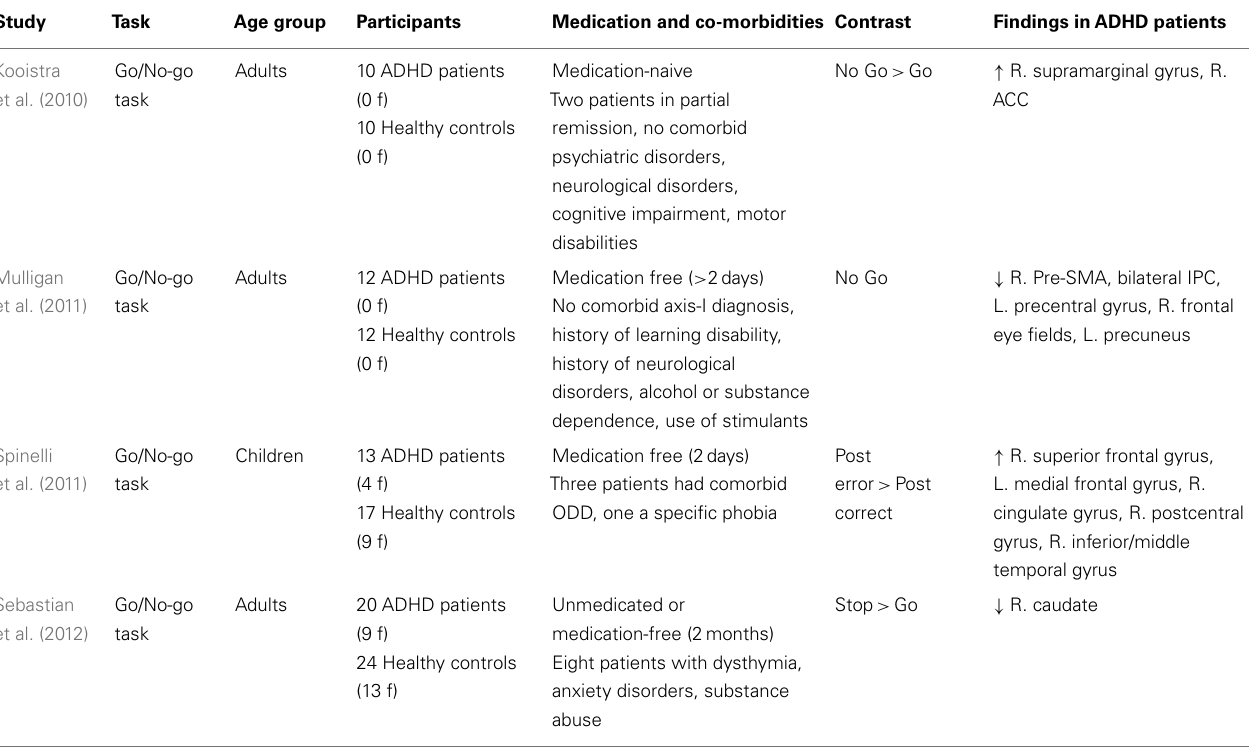
ACC,anteriorcingulatecortex;DLPFC,dorsolateralprefrontalcortex;FS,failedstop-trials;IFG,inferiorfrontalgyrus;IPC,inferiorparietalcortex;f,female;L,left;MPFC, medial prefrontal cortex; ODD, oppositional defiance disorder; OFC, orbitofrontal cortex; Pre-SMA, pre-supplementary motor area; R, right; SMA, supplementary motor area; SS, successful stop-trials.